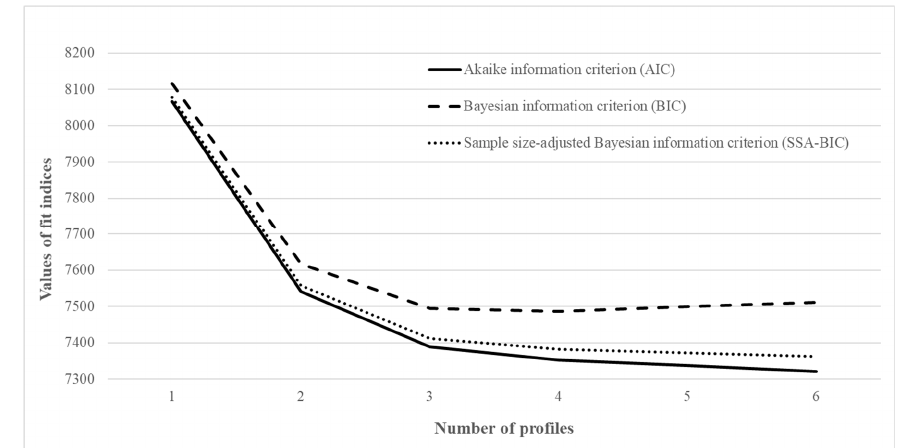
Figure 1. Elbow plot for the fit indices.